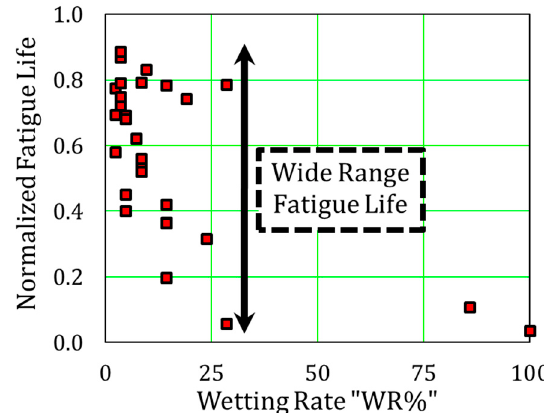
Figure 14. Location patterns of stagnant water.